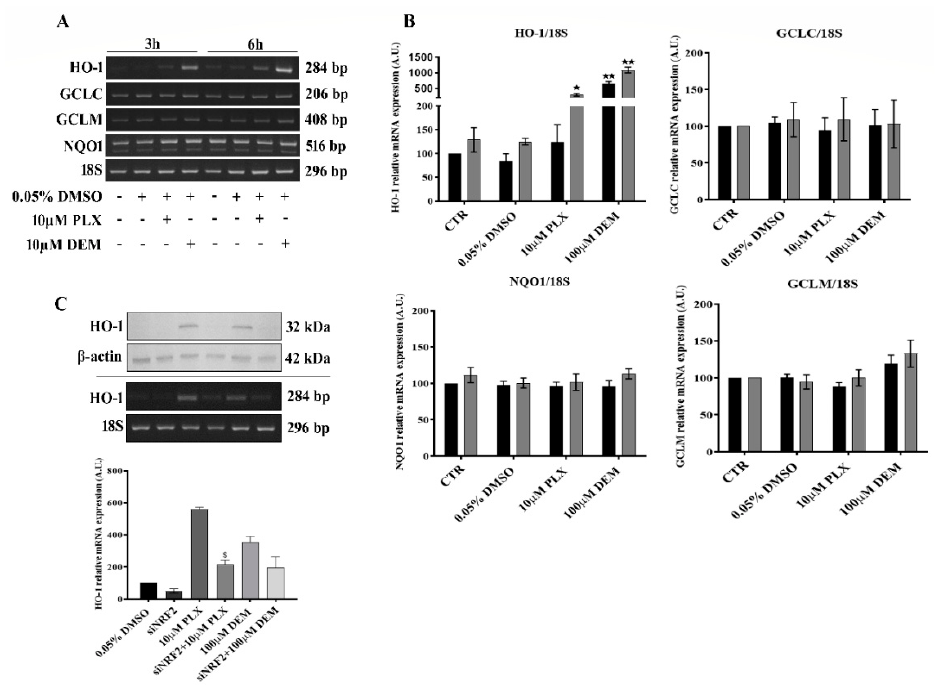
Figure 5. PLX4032 induces NRF2-dependent HO-1 expression. HO-1, GCLC, NQO1 and GCLM mRNA expression was assessed by RT-PCR in MeOV-1 cells treated with 10 μ M PLX4032 for 3 h and 6 h. Diethylmaleate (100 μ M DEM) was used as a positive control and 18S mRNA was used as a housekeeping gene. Representative blots of 3 independent experiments are shown in ( A ). Densitometric analysis for each gene shown in ( B ) where data denote mean ± S.E.M. (cid:70) p < 0.05 vs. respective CTR; (cid:70)(cid:70) p < 0.001 vs. CTR. The results of NRF2 silencing on HO-1 expression are shown in ( C ): HO-1 protein (upper) and mRNA (lower) expression were assessed by immunoblotting and by RT-PCR, using DEM as a positive control. Actin protein level and 18S mRNA were used as internal controls, respectively. Representative blots of 3 independent experiments are shown, with densitometric analyses of HO-1 mRNA expression. Data denote mean ± S.E.M. § p < 0.005 vs. PLX.